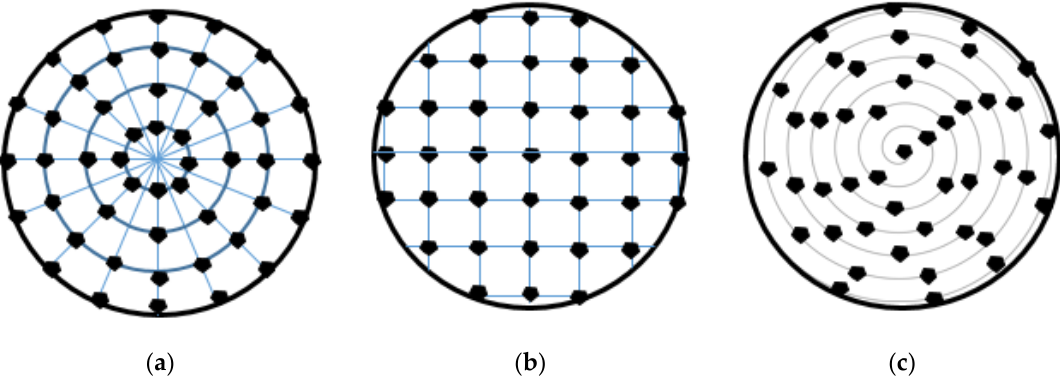
Figure 6. Schematic illustration of circular ( a ), rectangular ( b ) and spiral ( c ) patterns of abrasive grains arrangement in X-Y plane of grinding wheels studied in [29] and made by a stereolithography process.